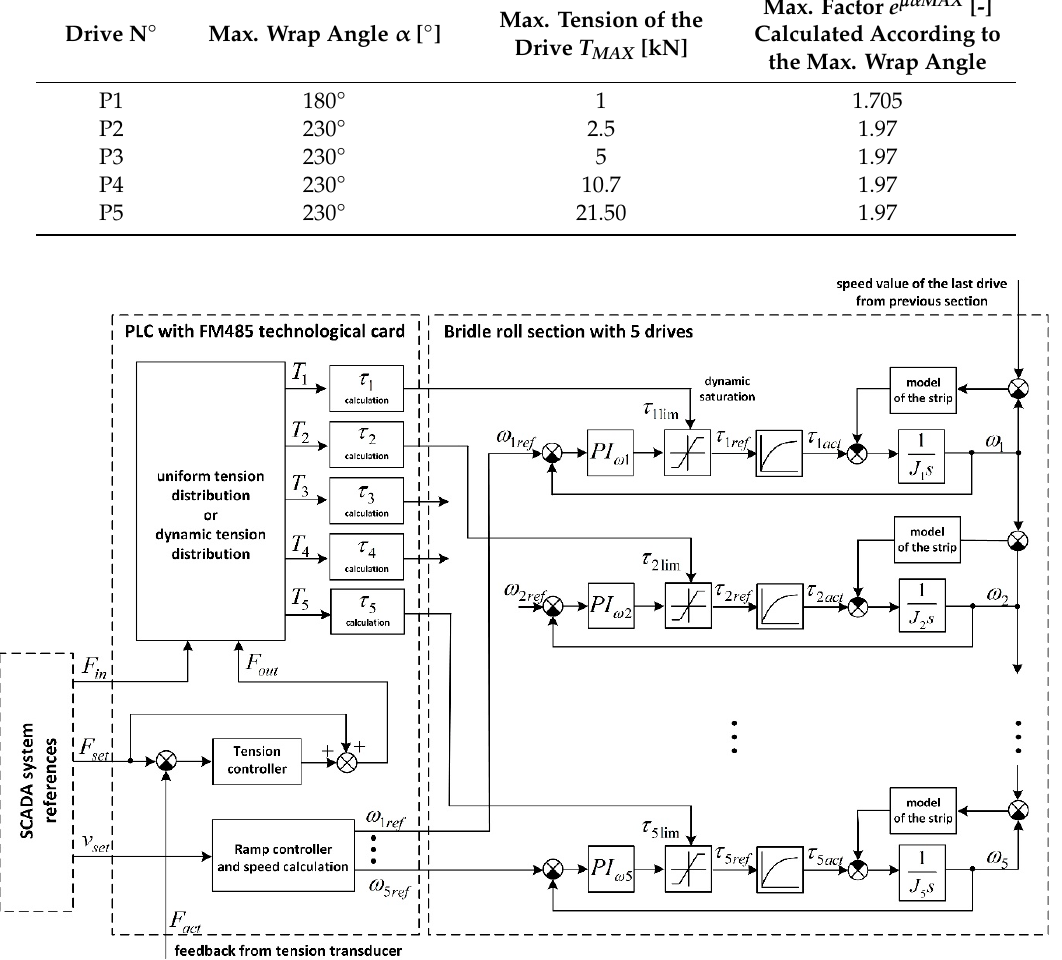
Figure 4. Symbolic control structure for the tension distribution algorithm for a leveler roll section with five drives. with five